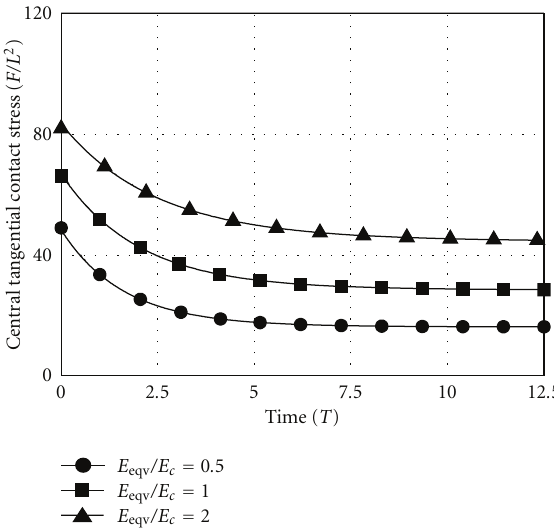
Figure 5: E ff ect of E eqv /E c on the contact pressure distribution.